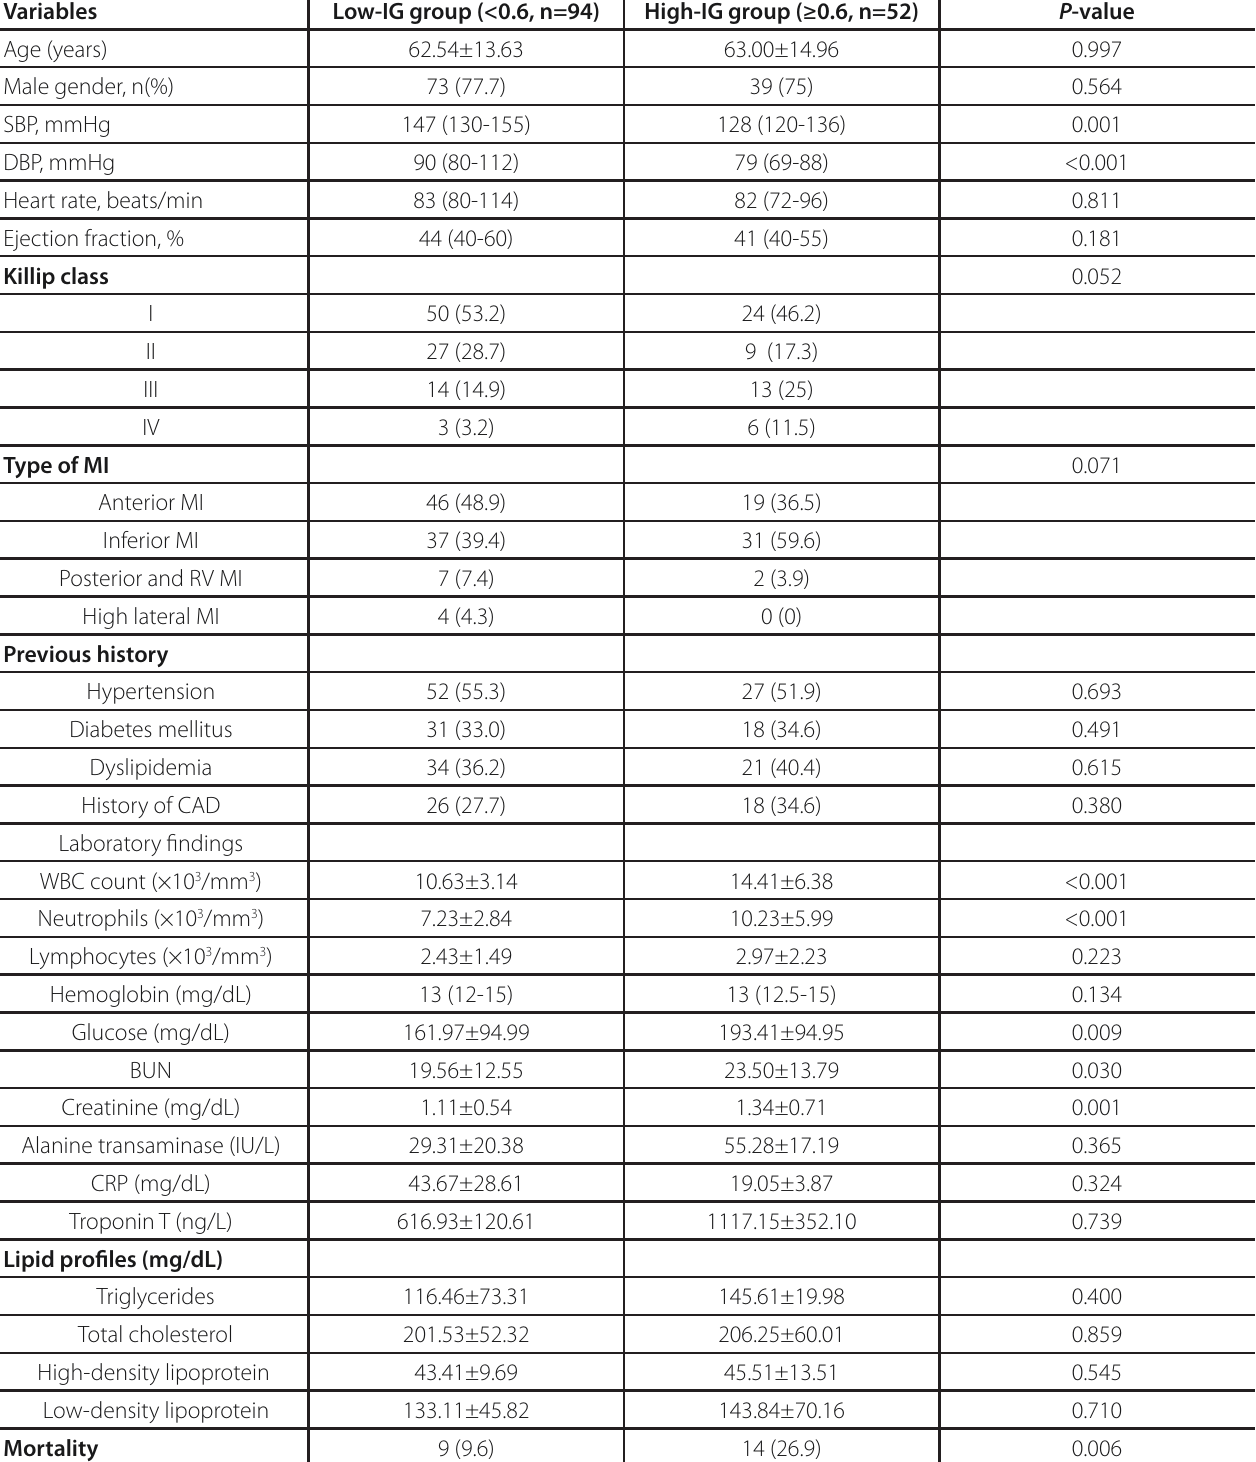
Table 2. Clinical and demographic characteristics of the study population.